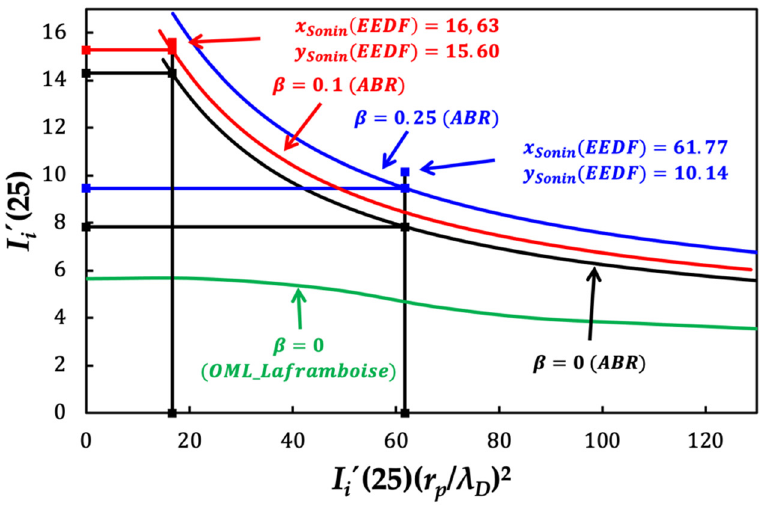
Figure 12. Theoretical Sonin Plot for the radial β = 0 (black), β = 0.1 (red) and β = 0.25 (blue) and orbital (green) theories. It also illustrates the cross plotting for y SP = 25 used for the calculation of n + .